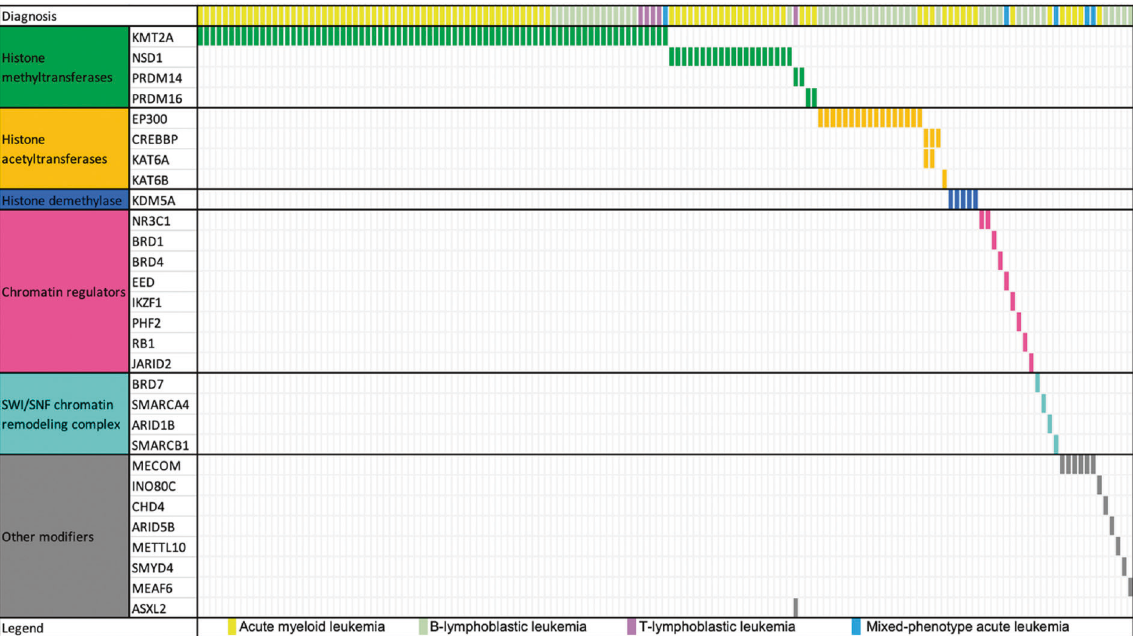
Fig. 5 The landscape of chromatin modi fi er fusions in different leukemia subtypes. The horizontal and vertical axes represent the patients and chromatin modi fi er genes, respectively. Genes were ordered based on chromatin modi fi er class. Color bar depicts the diagnosis of each